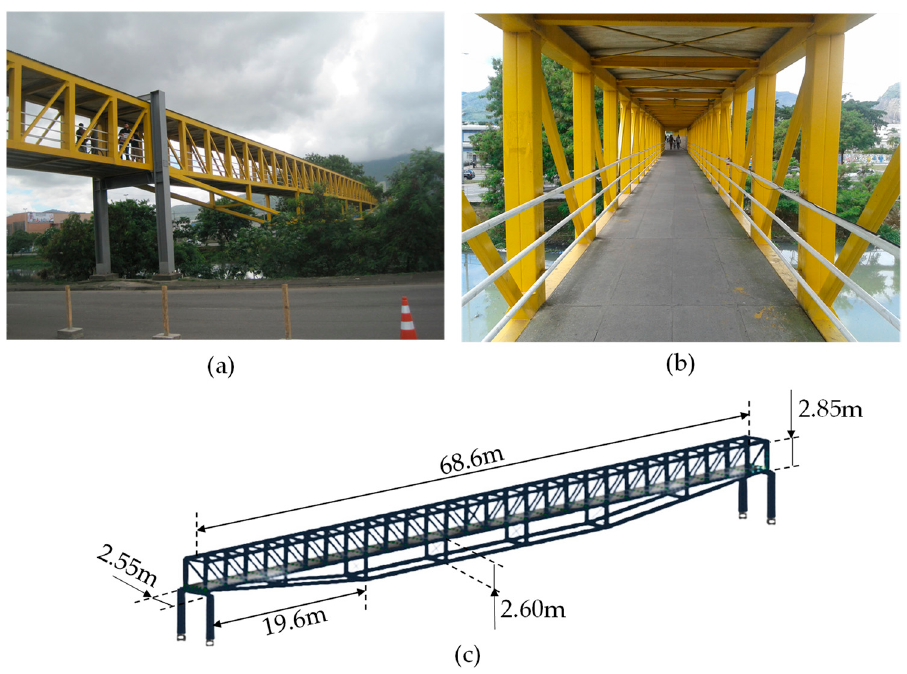
Figure 3. The analyzed footbridge. ( a ) External view, ( b ) internal view, and ( c ) 3D finite element model (FEM).